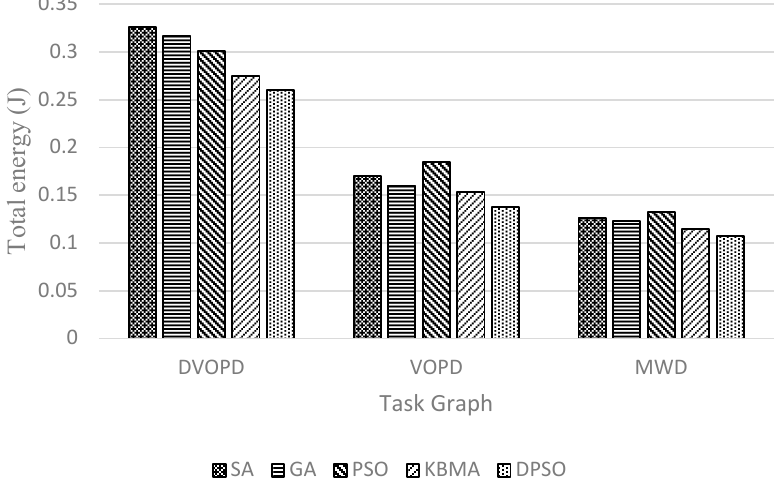
Figure 6. Heat loss at DVOPD, VOPD and MWD on 4 × 4 × 4 3D mesh structure.